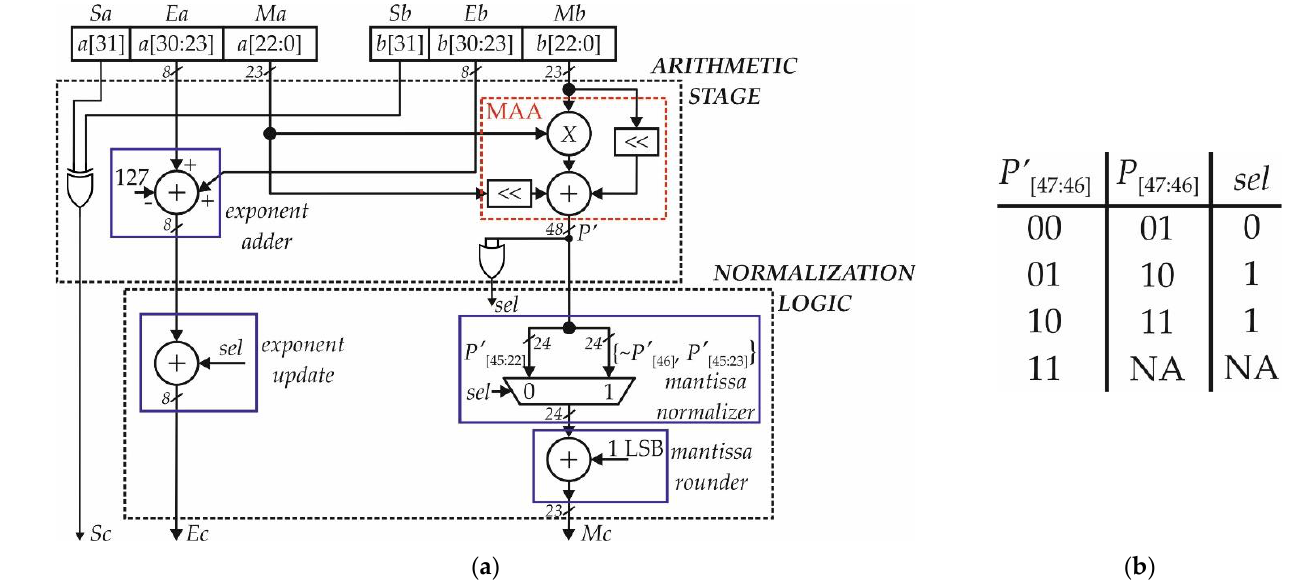
Figure 3. ( a ) Block diagram of the improved floating-point multipliers and ( b ) truth table that links the MSBs of P ’ and P . NA stands for not applicable.